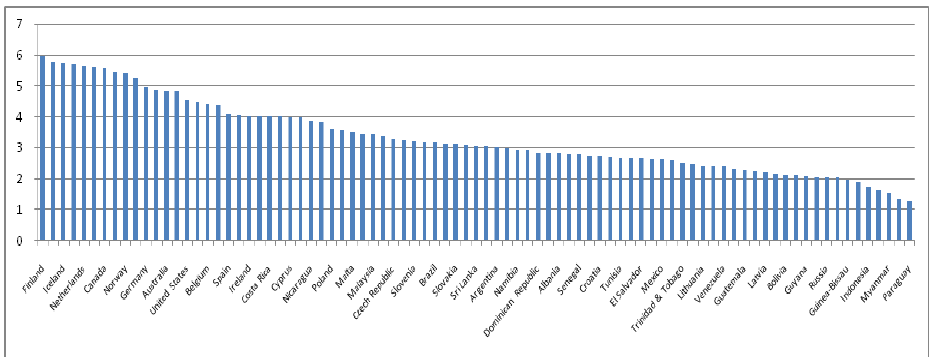
Figure 1. Mean of Corruption index over the